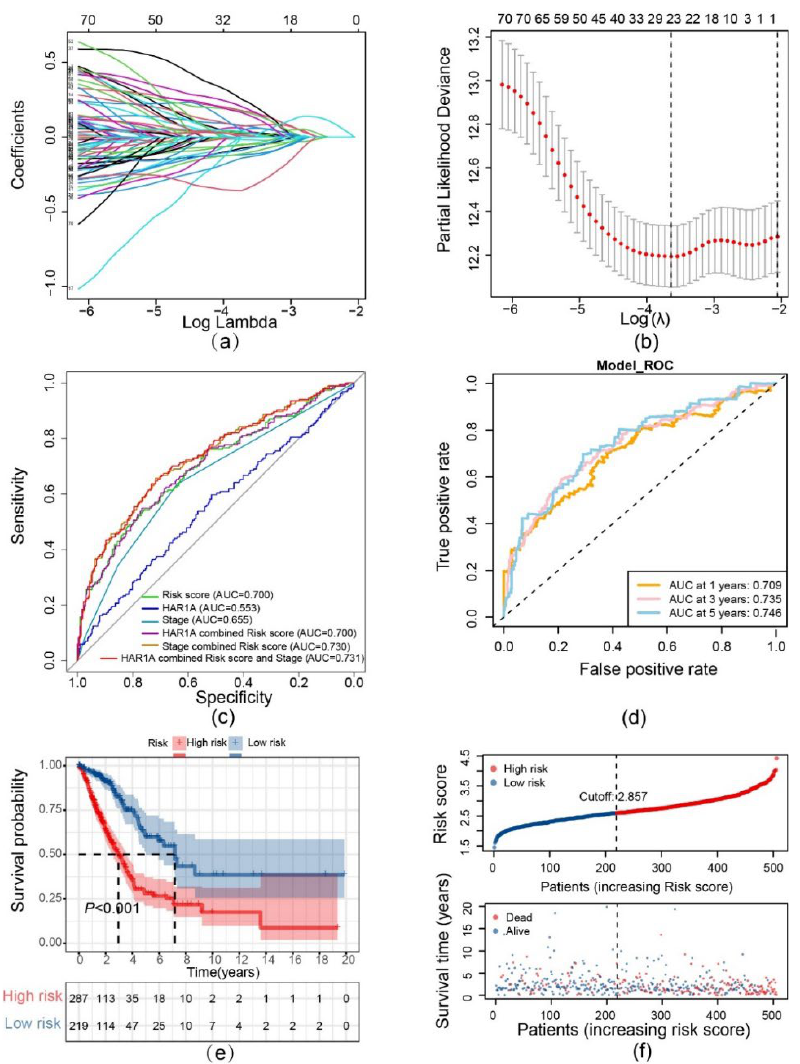
Figure 2. Construction and evaluation of the prognostic multiple-gene signature. ( a ) LASSO Cox regression coefficients of lncRNA HAR1A -related apoptosis/cell cycle genes. ( b ) Identification of the favorable gene signature using the LASSO model. ( c ) ROC curve analyses of the prognostic model, TNM stage, HAR1A , and indicated combinations. ( d ) Time-dependent receiver operator characteristic (ROC) curves trained on the risk scores were used to access AUC values for the TCGA-LUAD cohort, evaluating the overall accuracy of the model. ( e ) Kaplan–Meier survival curves of overall survival (OS) time between high- and low-risk patients. ( f ) The distribution of the risk score and survival status indicates that the survival time of patients descends while the risk scores are